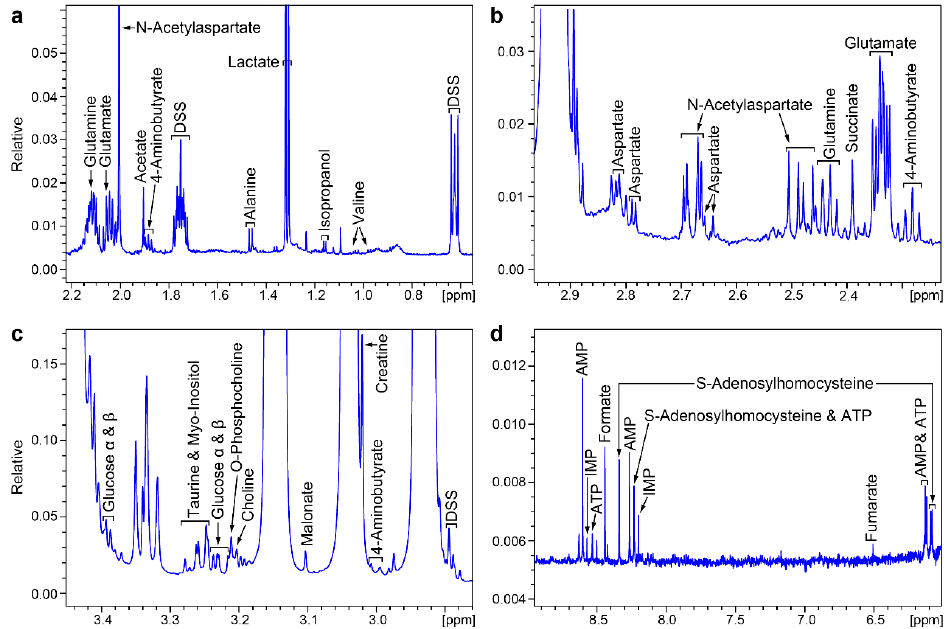
Figure 2. Identification of 20 synaptosomal metabolites in selected regions ( a ‒ d ) of the 1 H NMR spectrum shown in Figure 1.